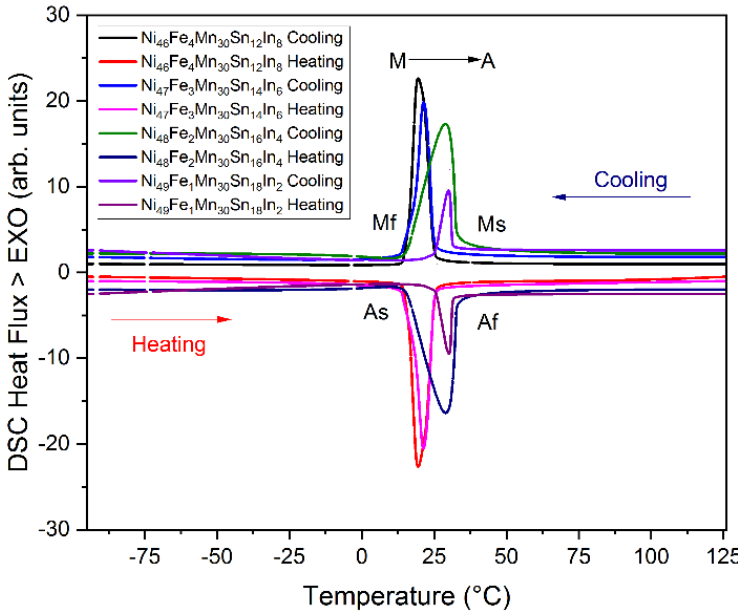
Figure 4. DSC plots for the sets of alloys.